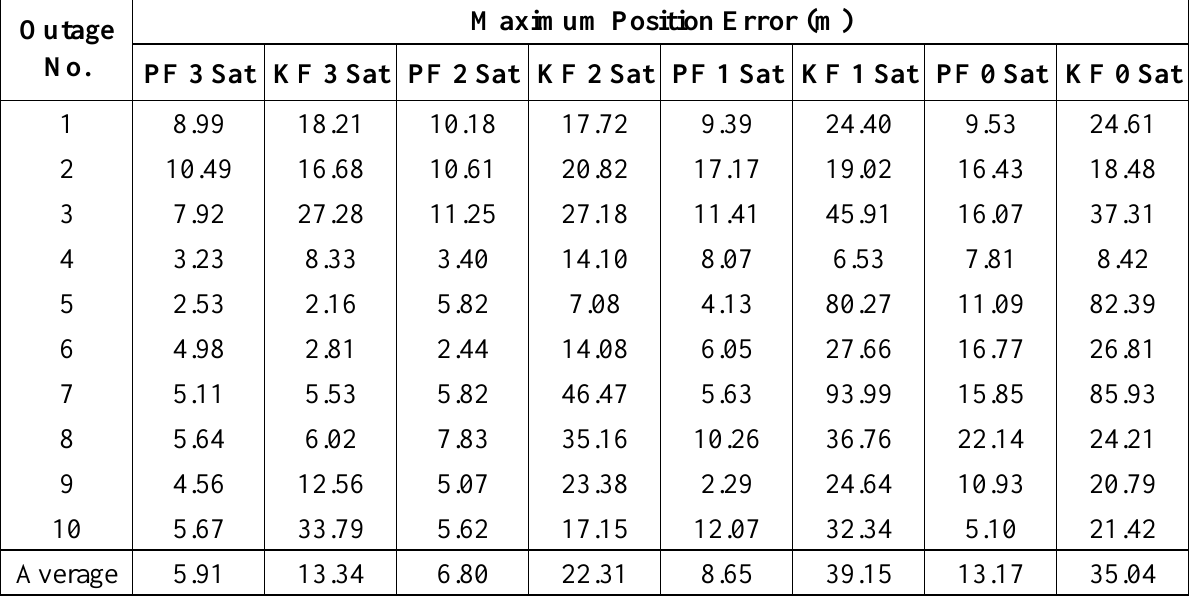
Table 3. Maximum position error during the 10 simulated outages for different numbers of visible satellites for the second trajectory.